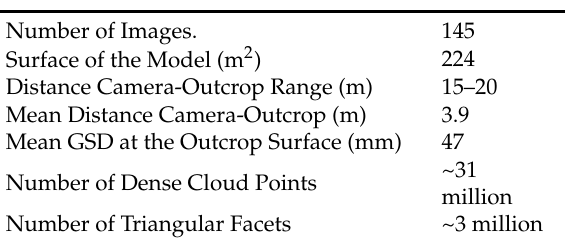
Table 3. Characteristics of DOM2.